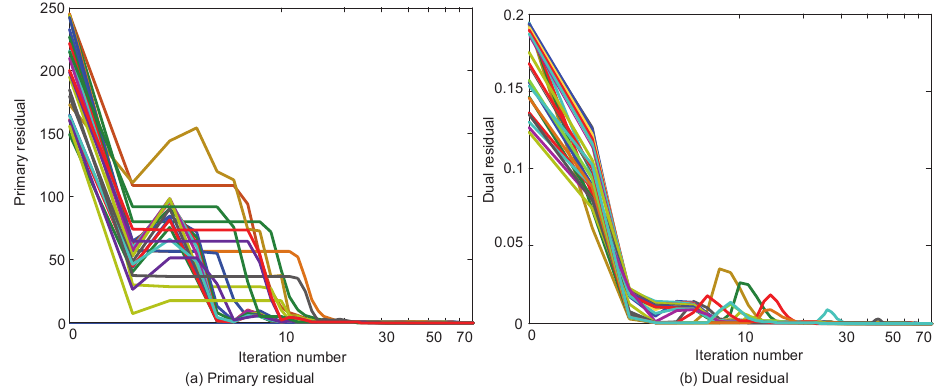
Figure 19. Iterative process of primal residual and dual residual on Day 2 of Scenario 1 (( a ) Primary residual; ( b ) Dual residual).